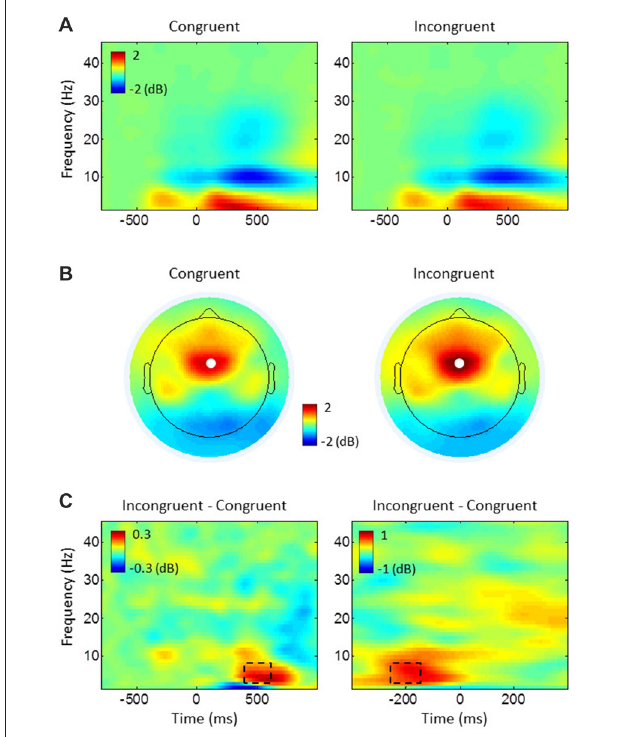
FIGURE 3 | Task-related power changes relative to baseline. (A) Stimulus-locked power plots, averaged over all electrodes and participants for congruent and incongruent. (B) Topography maps of theta (4–8 Hz) power, averaged from 400 ms to 600 ms of the stimulus-locked epochs in (A) . White dots represent the electrode FCz. (C) The difference between conditions (incongruent-congruent) for stimulus-locked epochs (left) in (A) and response-locked epochs (right), averaged over all participants at electrode FCz. Dashed rectangles represent time-frequency windows of interest used for medial frontal cortex (MFC) theta power